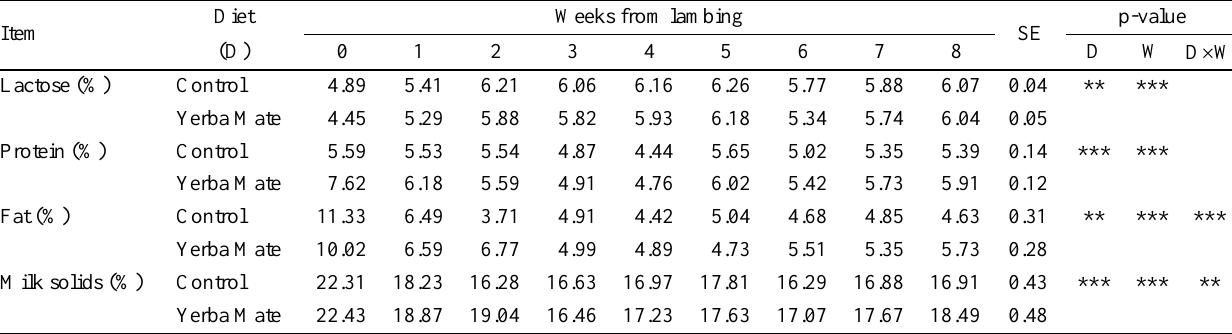
For parameters where a significant effect of the Diet  Week interaction was noted (fat % and milk solids) means with different superscript letters indicate significantly difference between groups (p<0.01).